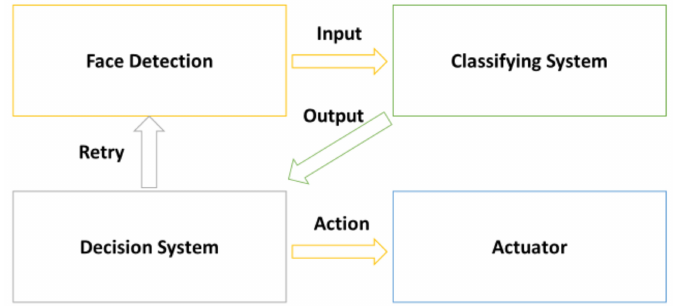
Figure 4. Block diagram of the system.